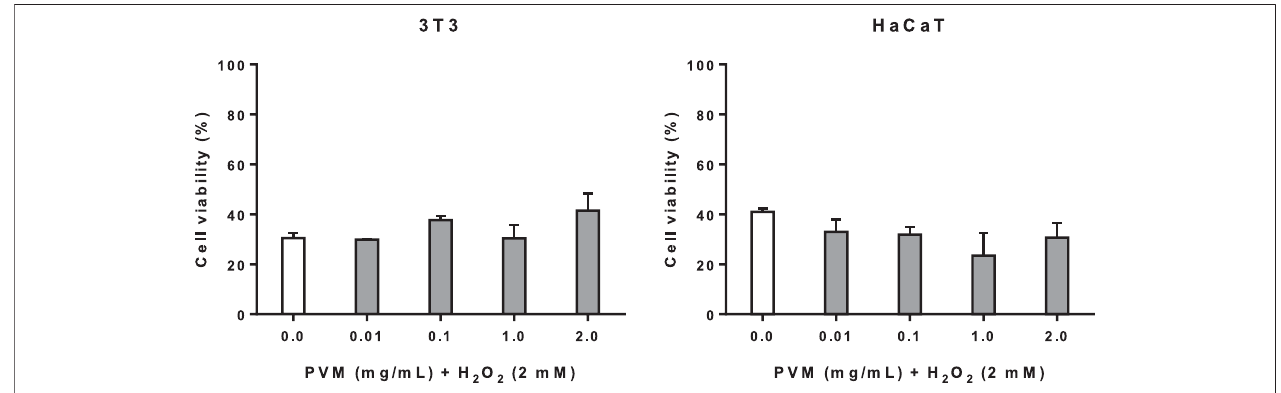
FIGURE 3 | Cytoprotective activity of PVM in 3T3 and HaCaT cell lines for 2 mM H 2 O 2 during 2.5 h by MTT assay and expressed as percentage of cell viability respect tountreated cellscontrol. H